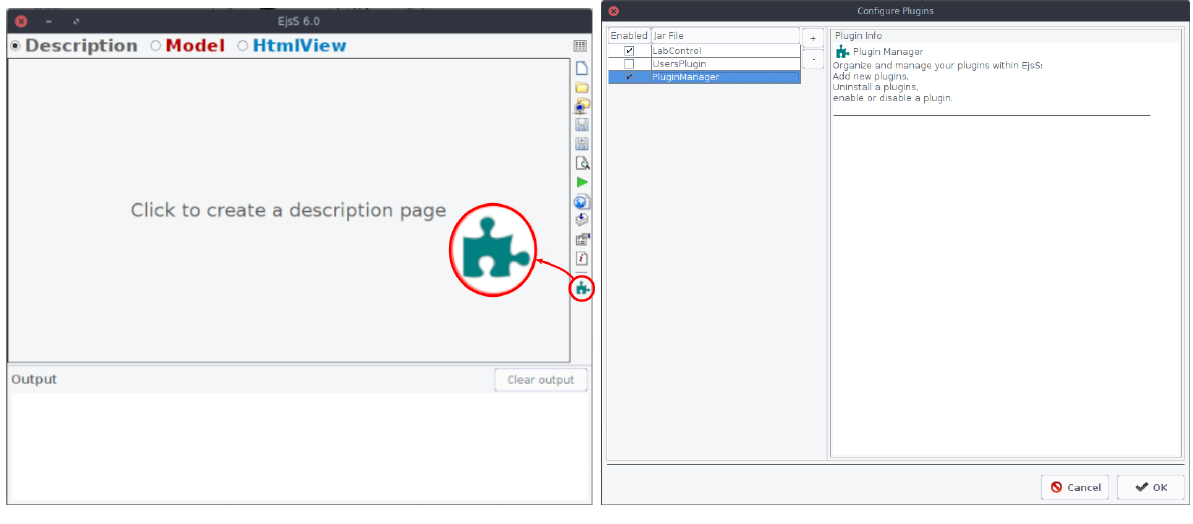
Figure 5. EJsS adapted with the Plugin